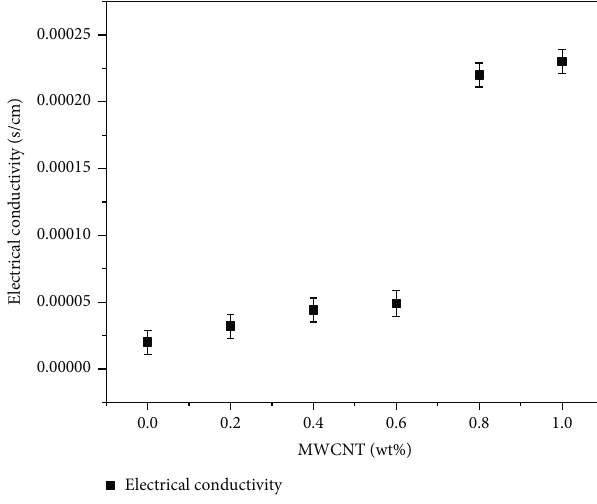
Figure 5: Electrical conductivity of